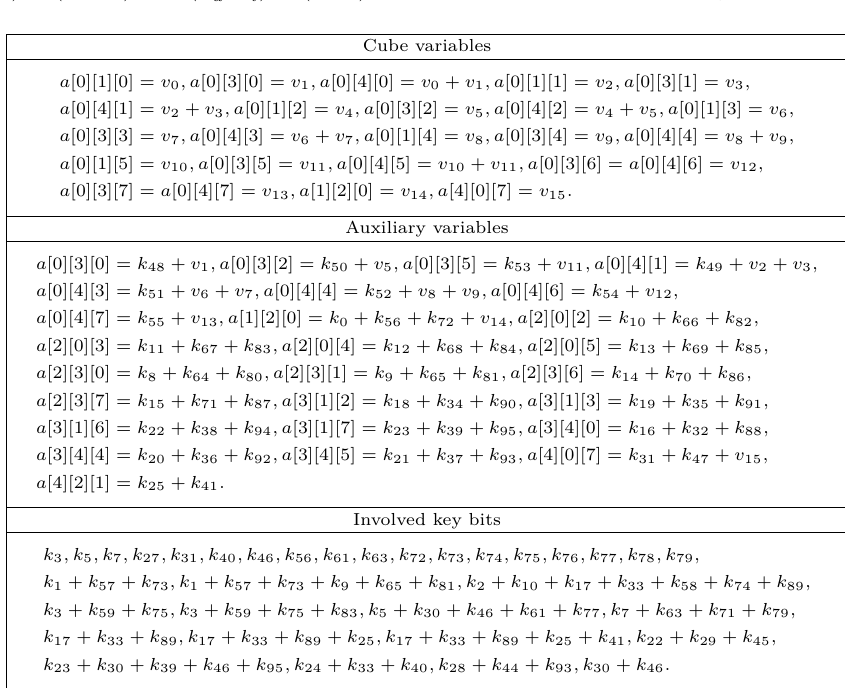
Table 11: The third 16-dimensional cubes for Ketje Jr V2, where the corresponding ( n a , n i ) is (26 , 32) and ( n 0